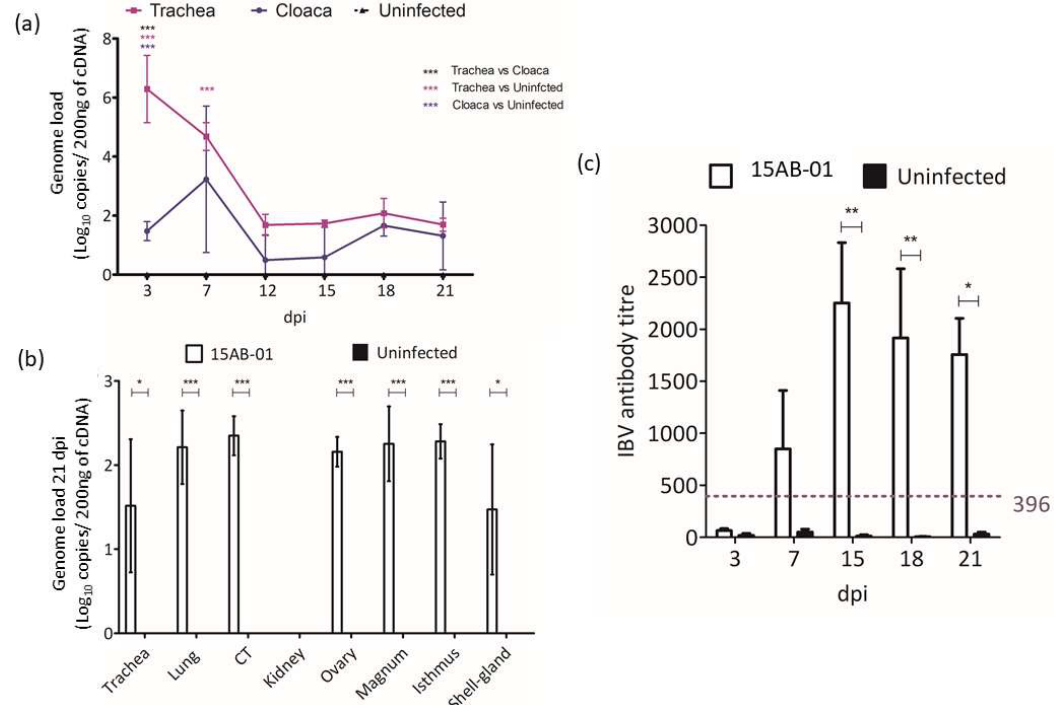
Figure 5. IBV genome load and anti-IBV antibody response following infection with Mass type Western Canadian IBV isolate, 15AB-01. Absolute genome loads for the tracheal and cloacal ( a ), and various tissue samples ( b ) are shown in the graphs. Absolute serum anti-IBV antibody titer is shown in graph ( c ) (dotted line indicates cut-off test value). Error bars indicate standard error of the mean (SEM). (key to statistical significance: * p < 0.05, ** p < 0.01, and *** p < 0.001).